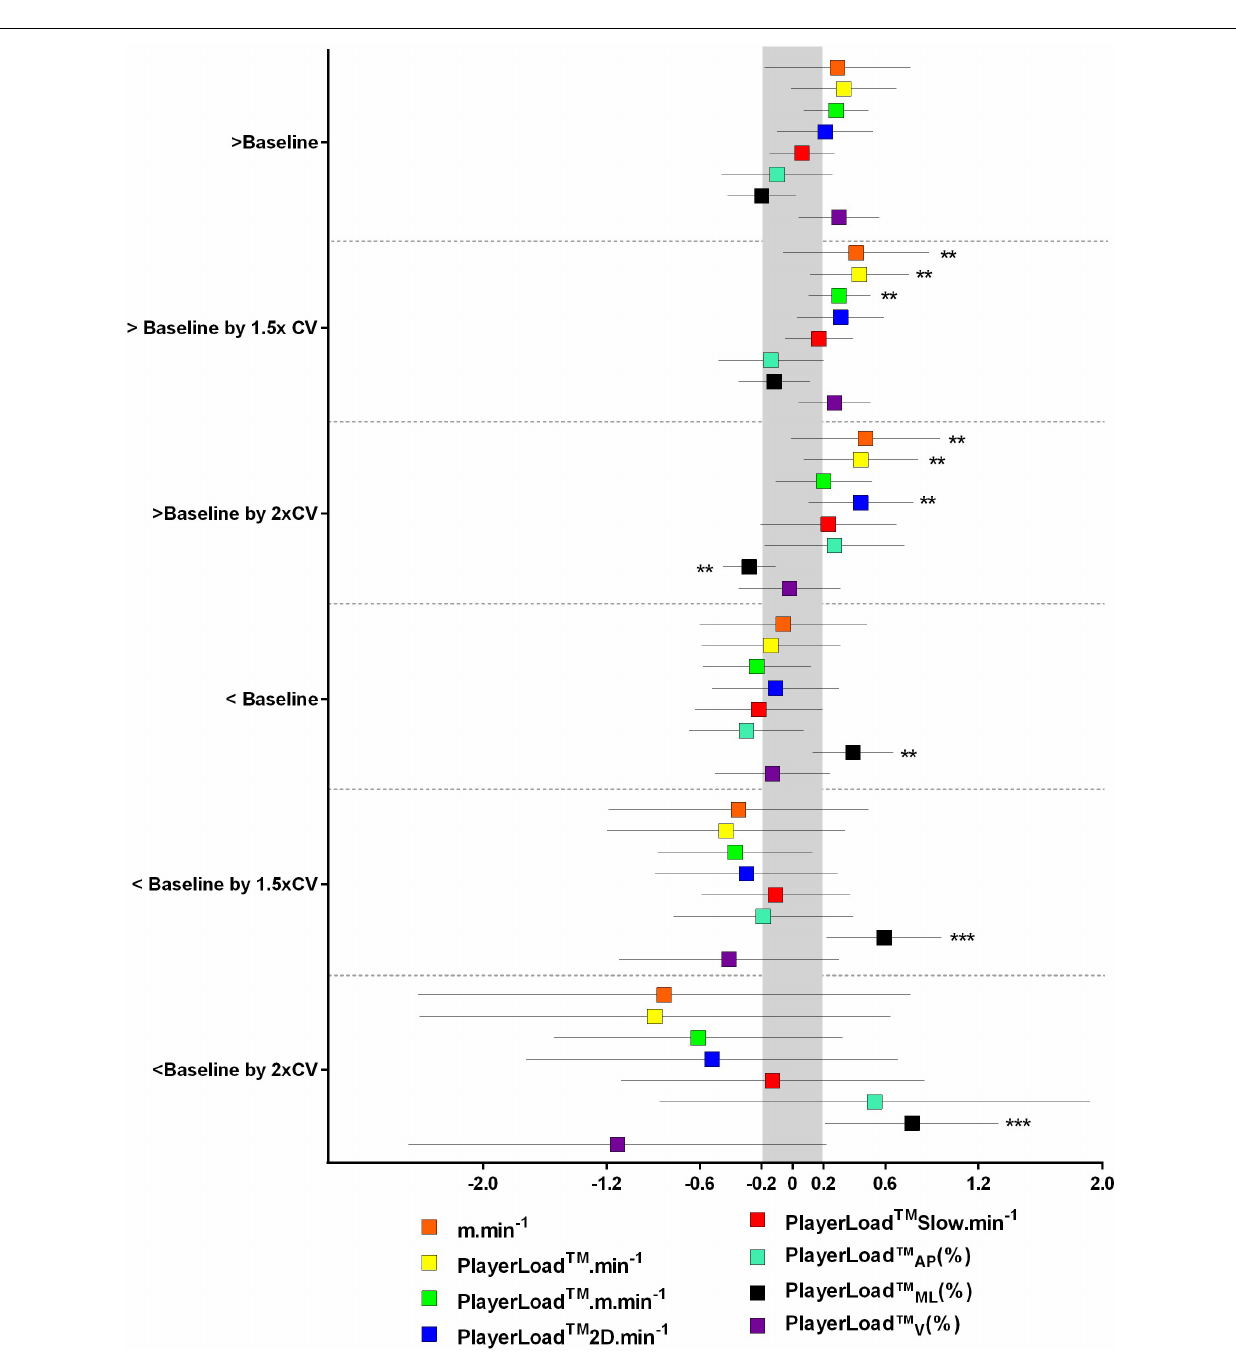
FIGURE 4 | Change in match exercise intensity based on small-sided game; SSG PlayerLoad TM Slow per minute; PLSlow · min − 1 < and > baseline, by more than 1.0, 1.5, and 2.0x %CV. Symbols denote a ∗∗ likely, ∗∗∗ very likley, and ∗∗∗∗ most likley chance that the change has exceeded the smallest worthwile change of 0.2 (shaded in